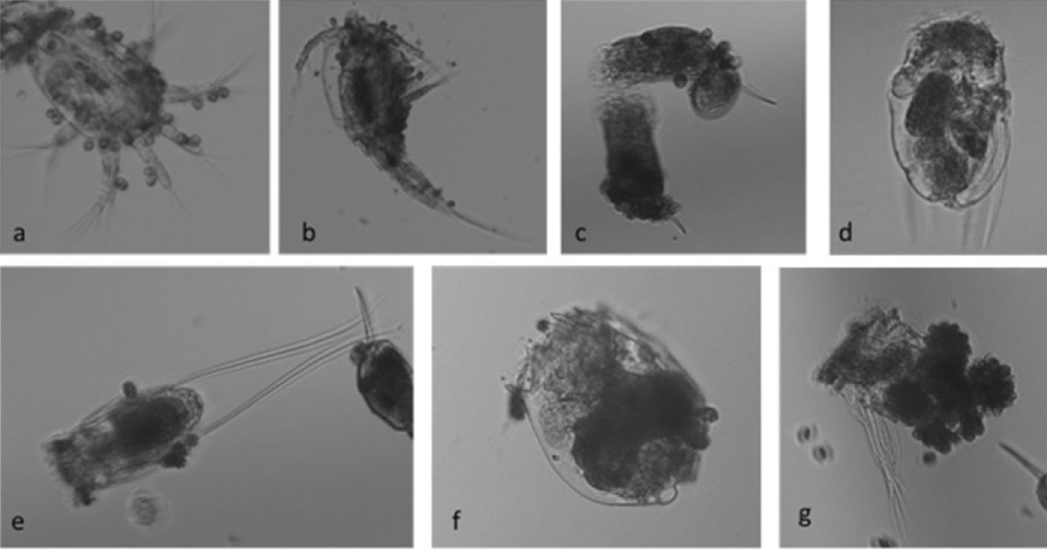
Figure 1. Zooplankton species loaded with epibionts ( a ) Copepod nauplii ( b ) Copepod adults ( c ) Keratella cochlearis ( d ) Polyarthra vulgaris ( e ) Filinia longiseta ( f ) Brachionus rubens ( g ) Hexarthra mira